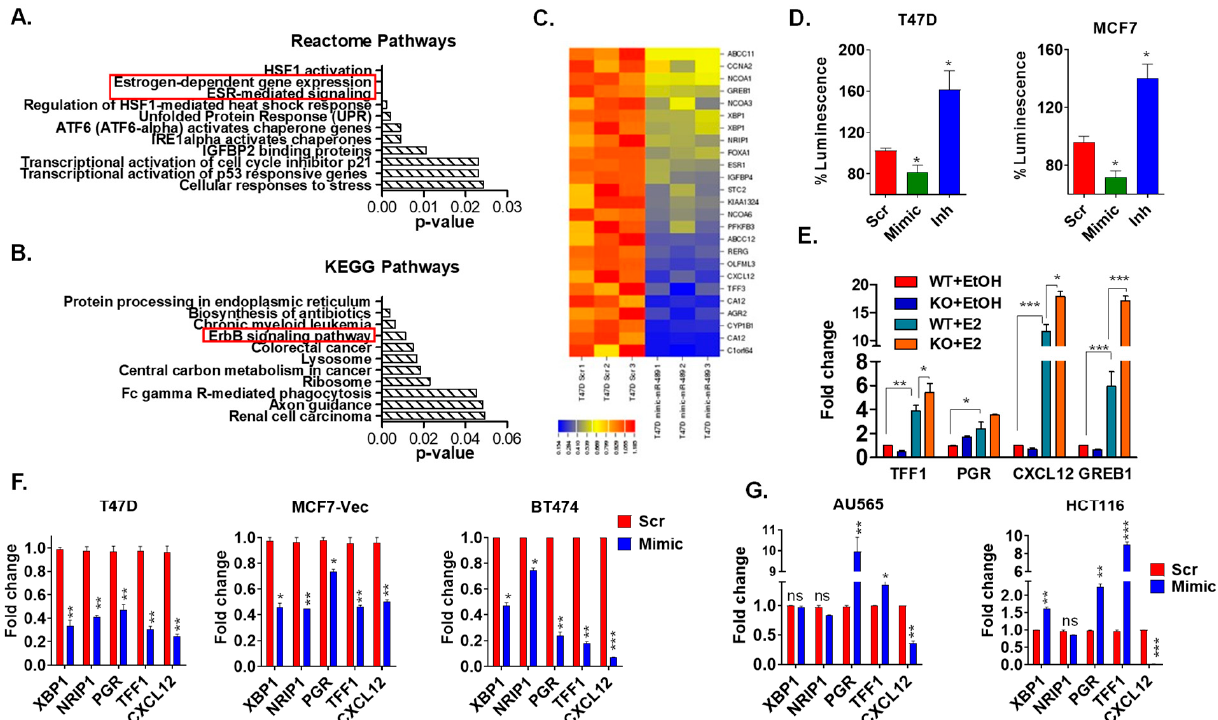
Figure 3. Gene expression analysis revealed enrichment of multiple pathways involved in estrogen signaling and tamoxifen resistance. ( A , B ) Whole-transcriptome analysis of miR-489-transfected and control T47D cells followed by pathway enrichment analysis revealed multiple pathways involved in tamoxifen resistance, including ESR-mediated signaling and ErBB2 pathways. ( C ) Heatmap demonstrating downregulation of multiple estrogen-responsive genes in miR-489-transfected T47D cells. ( D ) miR-489 negatively regulated estrogen-induced transcription by transient transfection of cells with the ERE-reporter system. ( E ) miR-489 WT and knockout T47D cells were treated with ethanol or estrogen for 6 h, and expression of estrogen-responsive genes was examined using qRT-PCR. ( F , G ) qRT-PCR analysis of estrogen-responsive genes upon miR-489 restoration showed downregulation of estrogen-responsive genes only in ER+ breast cancer cell lines. ns, not significant; * p < 0.05; ** p < 0.01; *** p < 0.001. Data are representative of three independent experiments.